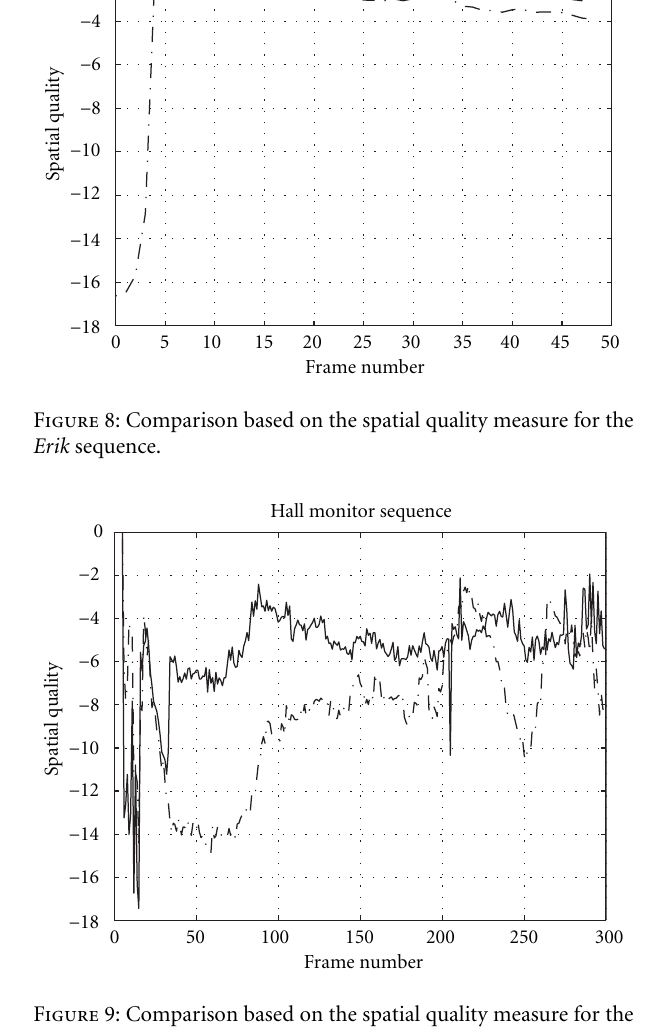
Figure 9: Comparison based on the spatial quality measure for the Hall monitor